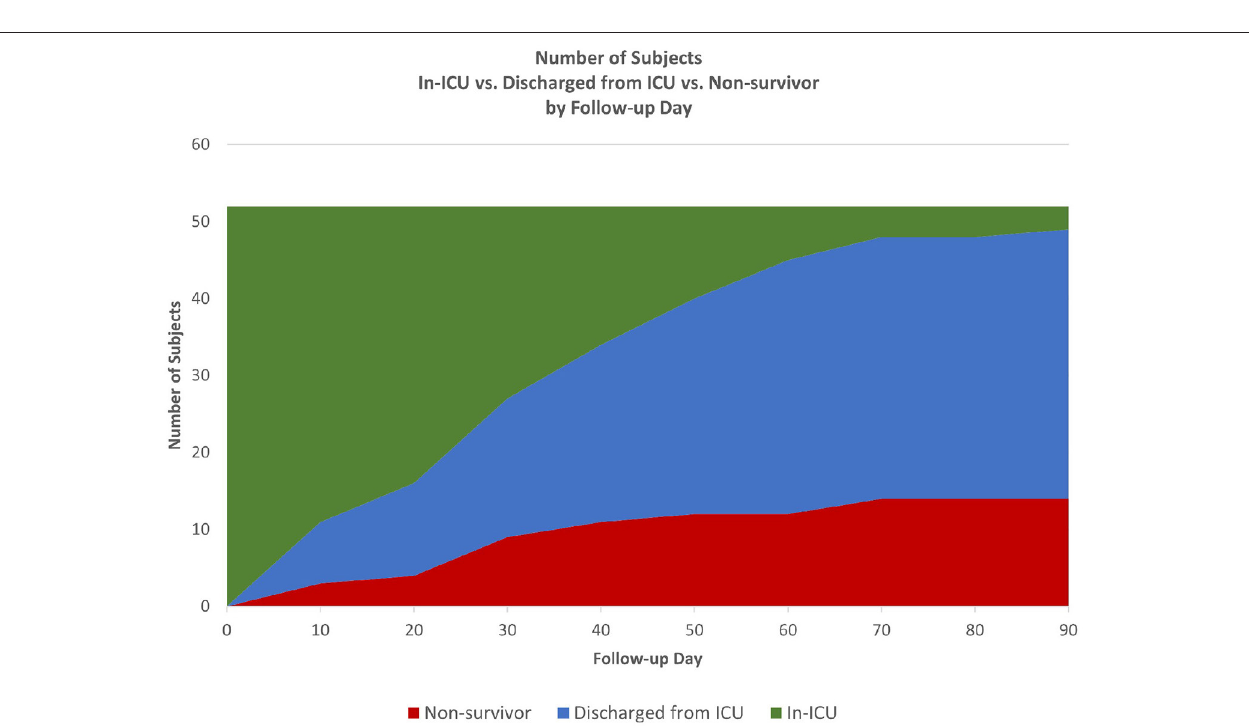
FIGURE 2 | Patient disposition from start of CytoSorb therapy to 90 days. Stacked Area Graph showing the disposition of the CTC cohort following start of CytoSorb therapy in the ICU. circuit was generally well-tolerated without any unanticipated device-related adverse events. Further studies are needed to determine if the non-significant trends reported above help to